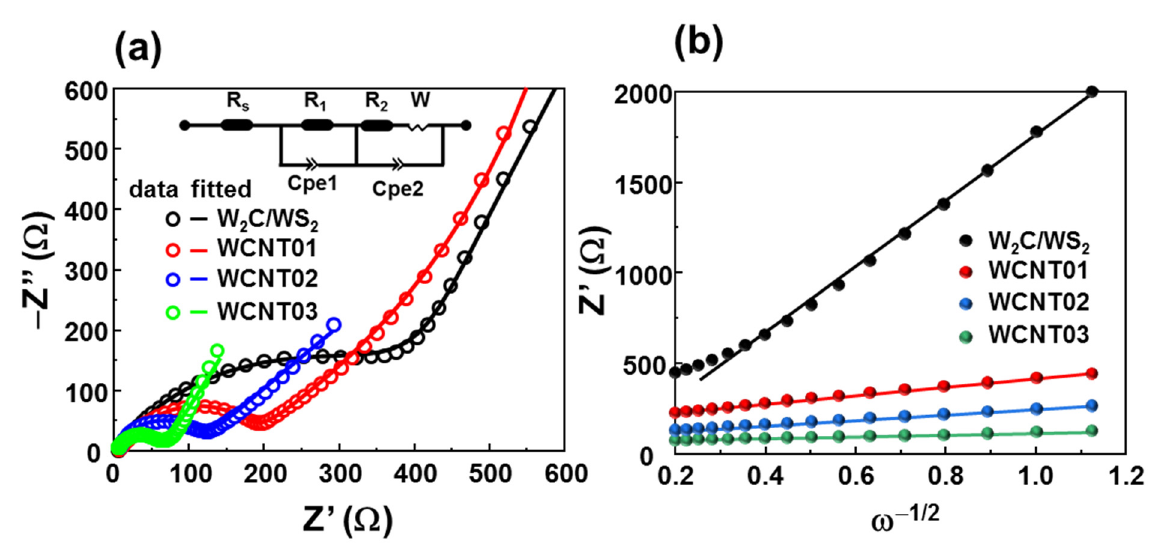
Figure 7. ( a ) Nyquist plots and ( b ) Z’ vs. 𝜔 (cid:2879)(cid:2869)/(cid:2870) plots of the bare W 2 C/WS 2 alloys and WCNT01/02/03